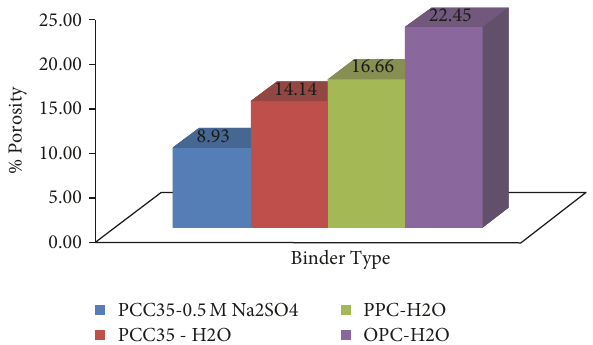
Figure 3: Porosity of 28-day cured mortar prisms versus binder types. Figure 4: Concentration of chloride ions (g/g of cement) mortar versus depth (mm).